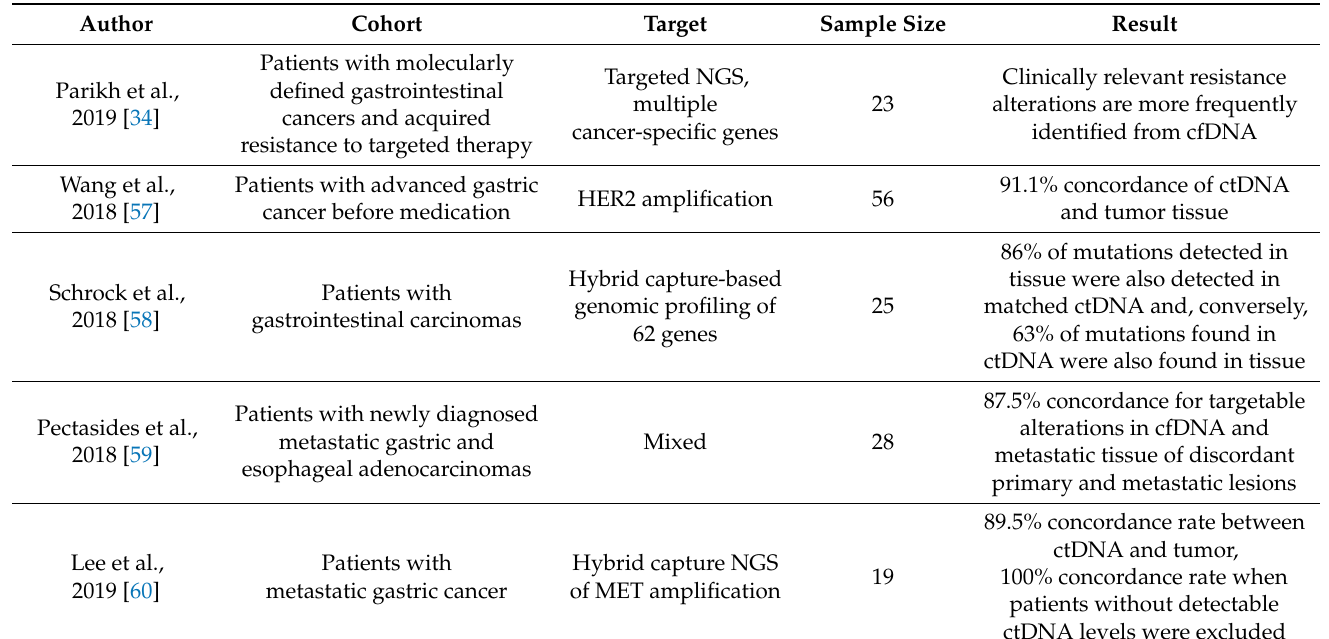
Table 1. Studies with comparative analysis of genomic profiling using liquid biopsy and matched tissue biopsy in gastric cancer.